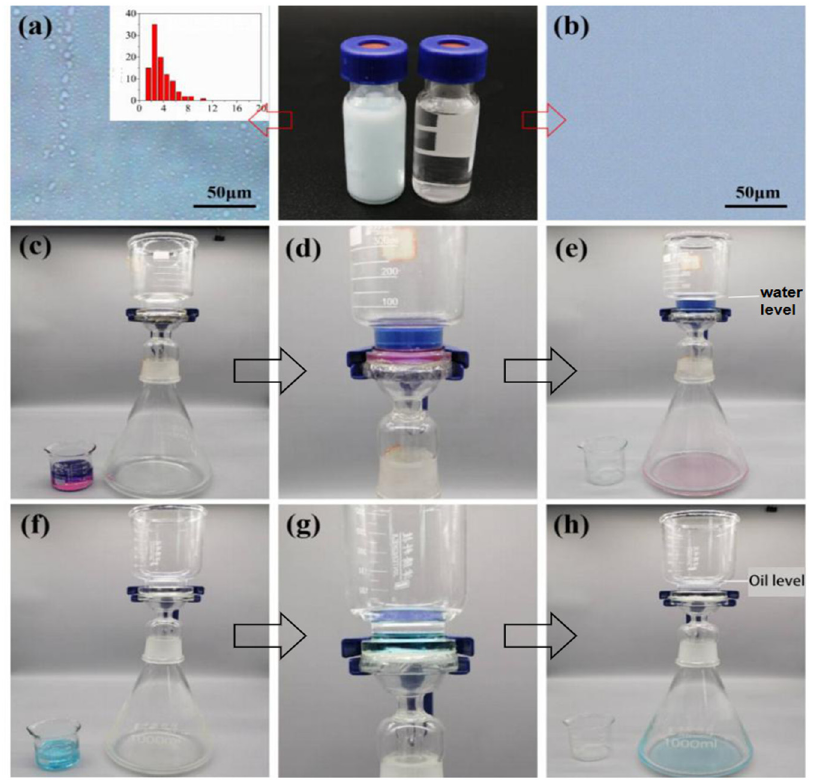
Figure 16. Janus–CA oil–water separation diagram. ( a , b ) Separation of the water-in-toluene emulsion, ( c - e ) Separation of the water and 1,2-dibromoethane mixture, ( f - h ) Separation of the ( c – e ) Separation of the water and 1,2-dibromoethane mixture, ( f – h ) Separation of the water and water and n-hexane mixture. n-hexane